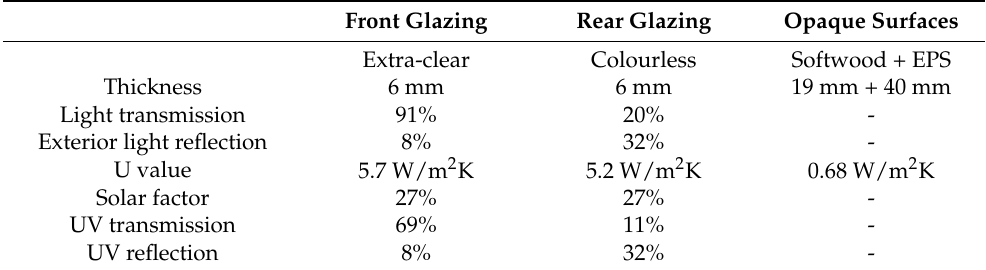
Table 1. Physical characteristics of the model’s envelope materials. Source: provided by Ariño Duglass [40] and from CTE